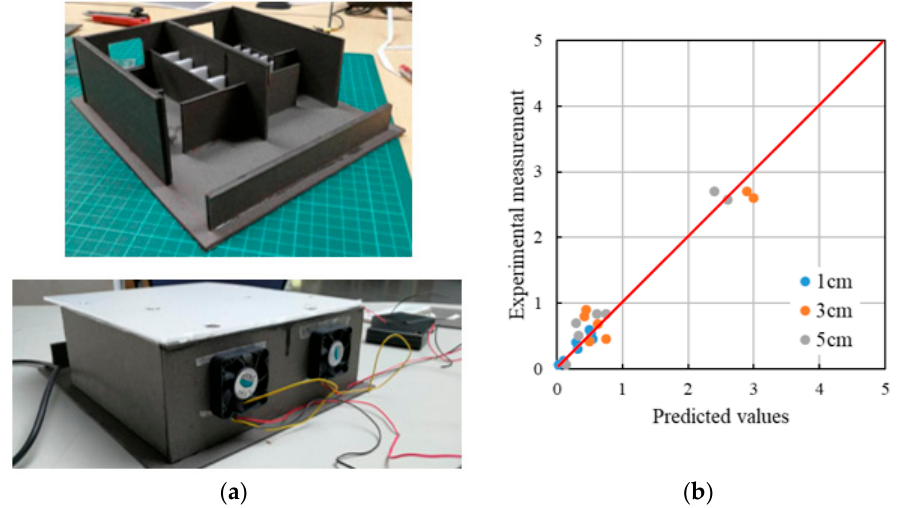
Figure 4. Comparison between the simulation results and the measurements. ( a ) Reduced scale model. ( b ) Predicted values versus simulation results.